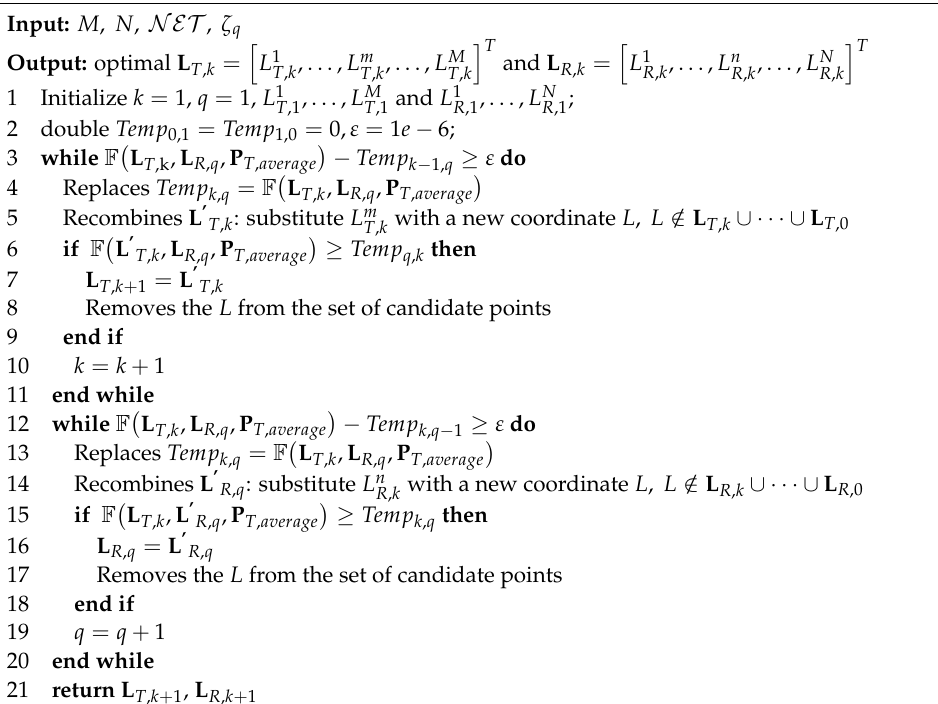
Algorithm 1: Two-stage greedy dropping heuristic local search for antenna